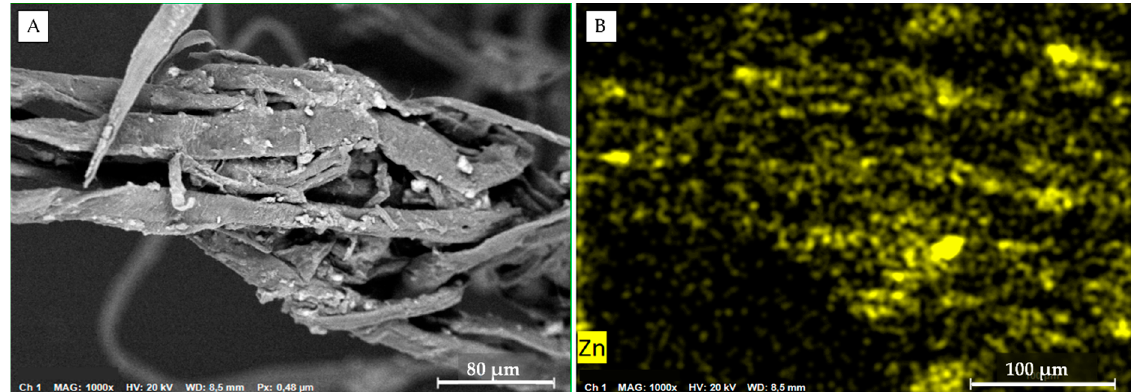
Figure 4. SEM images in D. polymorpha’ feces: ( A ) SEM image with evidence of aggregates on the fibers; ( B ) SEM-EDS image of faces clearly showing the presence of Zn (yellow dots).